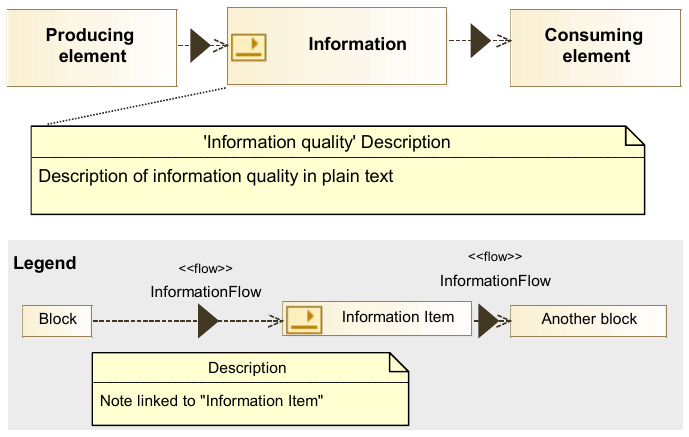
Figure 11. Information model.